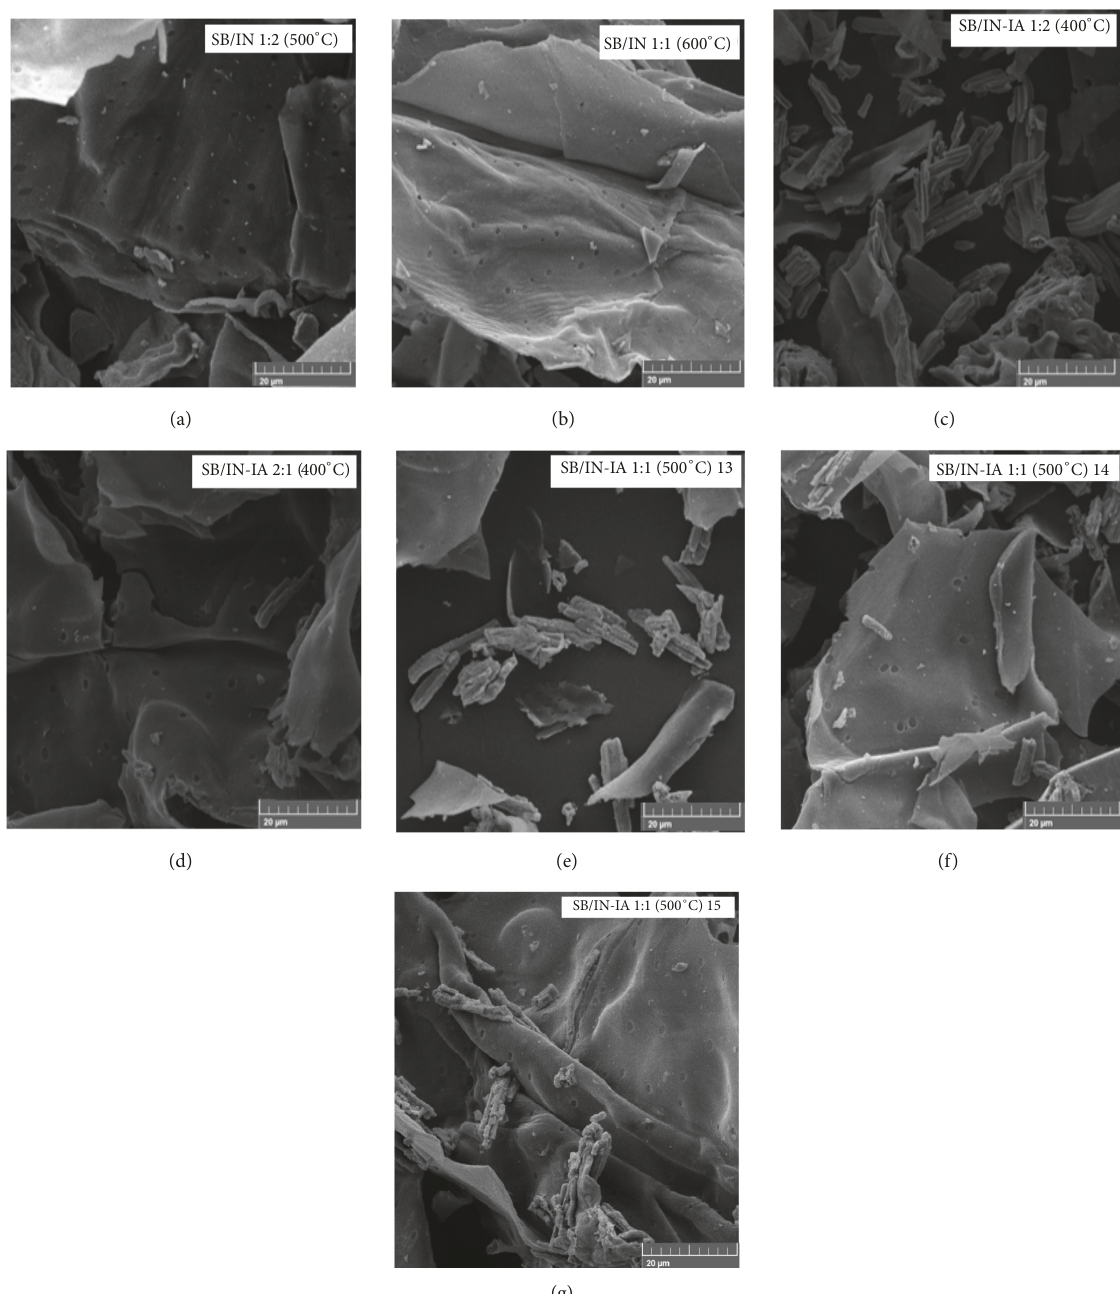
Figure 4: SEM images for composites (a) SB/IN 1:2 (500 ∘ C), (b) SB/IN 1:1 (600 ∘ C), (c) SB/IN-IA 1:2 (400 ∘ C), (d) SB/IN-IA 2:1 (400 ∘ C), (e) SB/IN-IA 1:1 (500 ∘ C) 13, (f) SB/IN-IA 1:1 (500 ∘ C) 14, and (g) SB/IN-IA 1:1 (500 ∘ C)